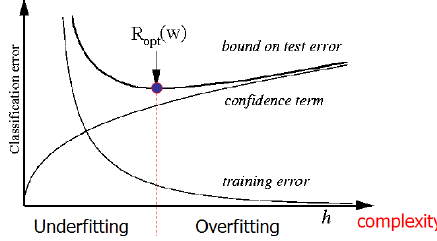
Figure 6. Controlling Complexity (Andrew W.